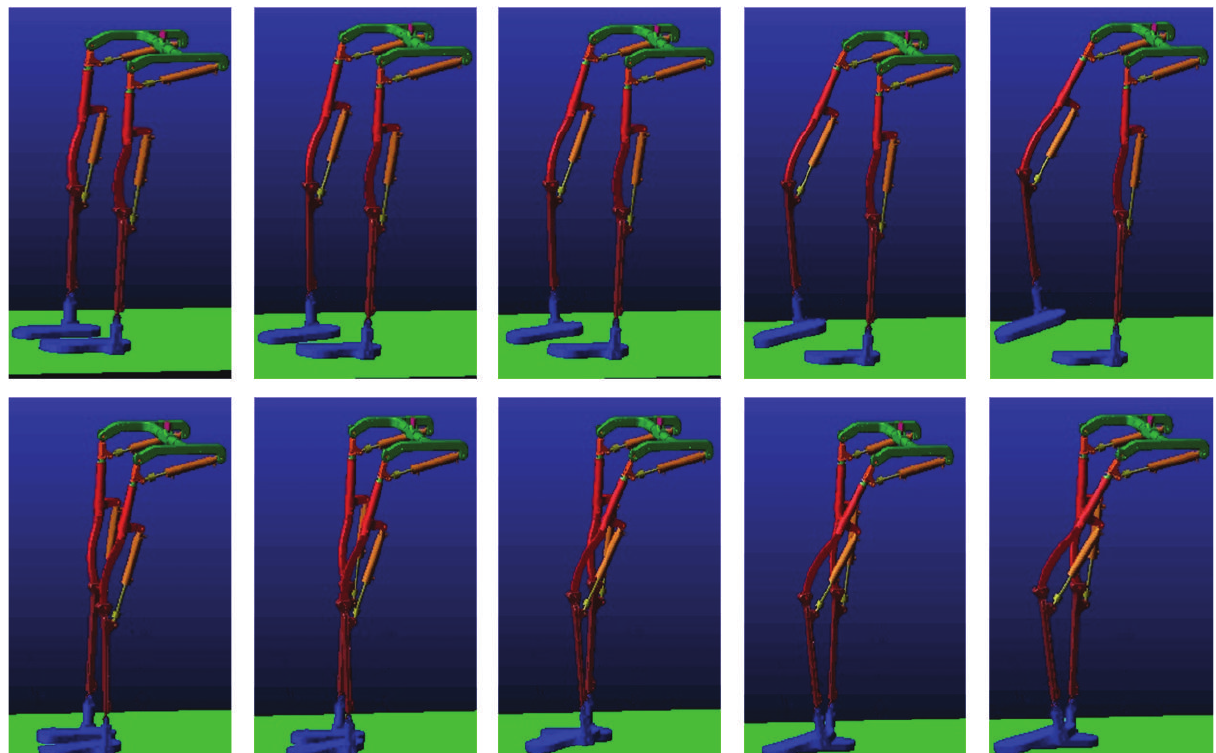
Figure 7: ADAMS effect pictures of gait cycles for lower extremity